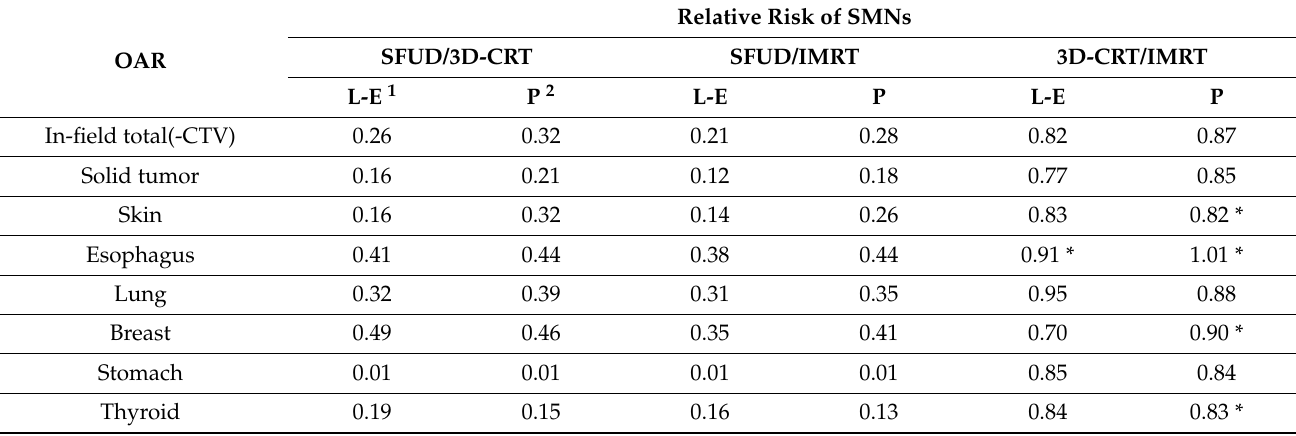
Table 6. Relative risk of SMNs.